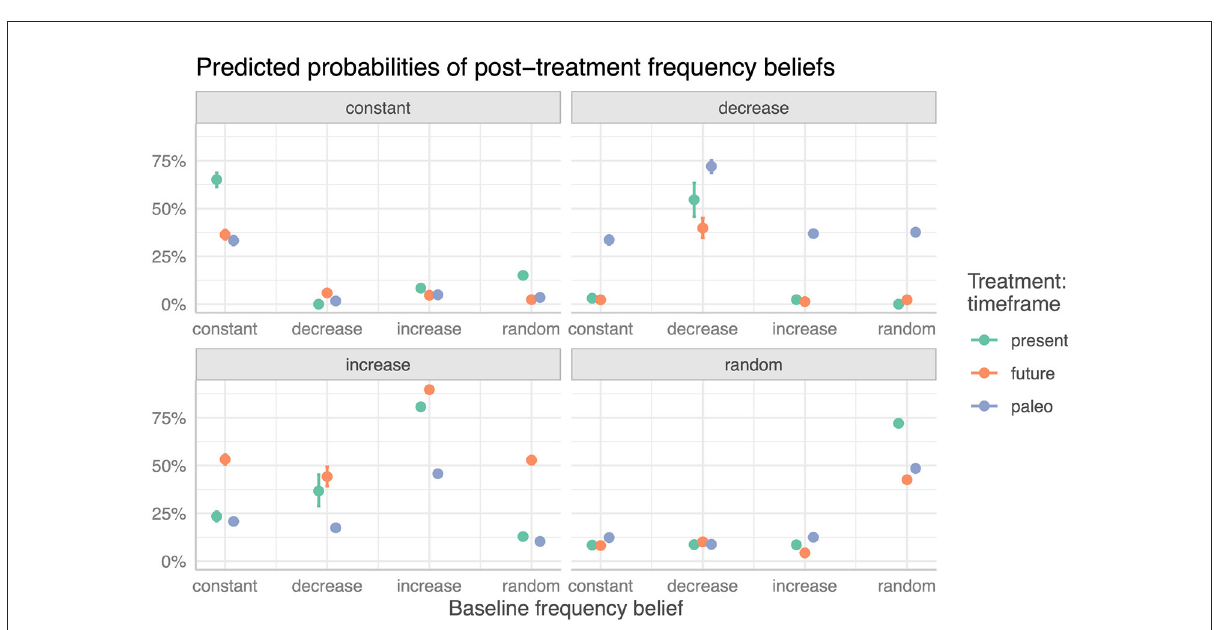
FIGURE3 Plot of post-treatment probabilities for beliefs about change in hurricane frequency by pretreatment frequency beliefs and assigned infographic treatments.